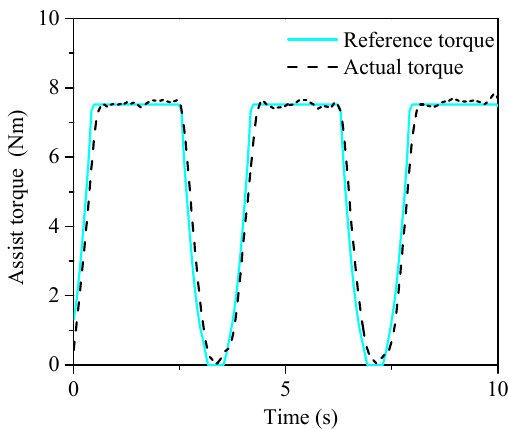
Figure 30. Actual torque at 40 km/h velocity under the PID control algorithm.